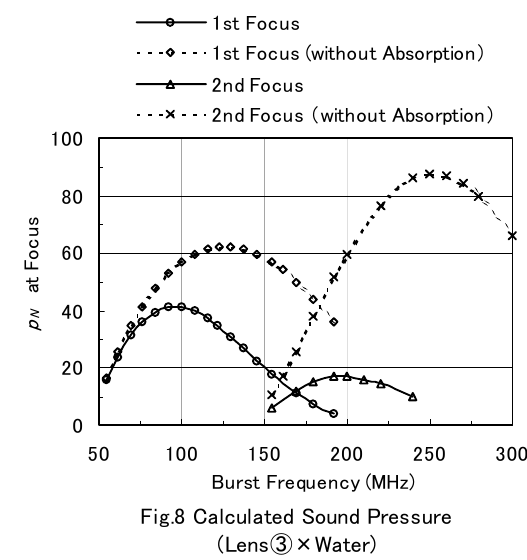
Fig.8 Calculated Sound